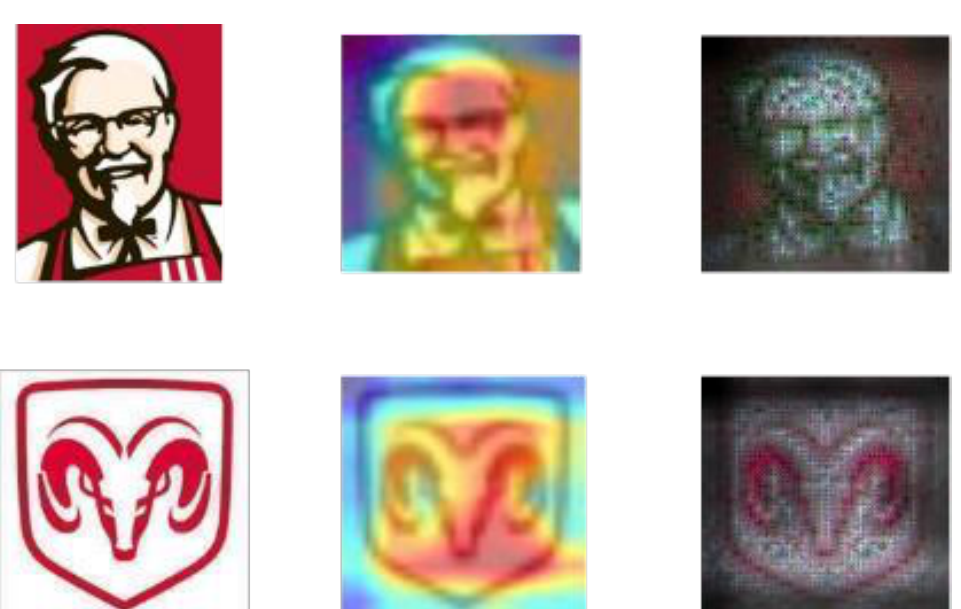
Figure 1. Schematic diagram of attention mechanism in trademark image.